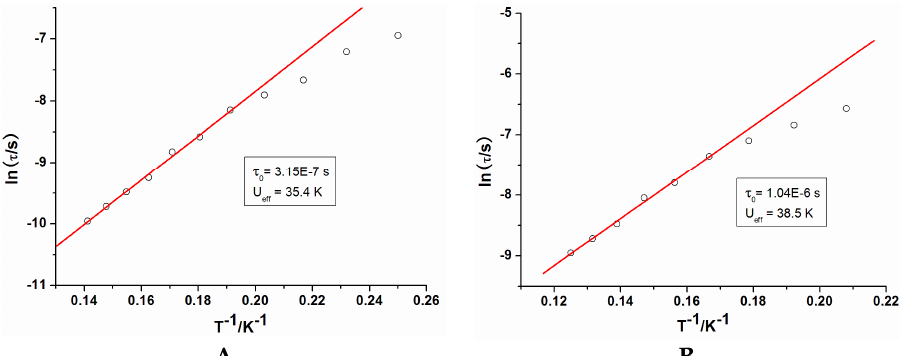
A B Figure 4. Magnetization relaxation time ( τ ) vs. 1/T plots for 1 ( A ) under 2000 Oe dc field and 2 ( B ) Figure 4. Magnetization relaxation time ( τ ) vs. 1/ T plots for 1 ( A ) under 2000 Oe dc field and 2 under a zero dc field. ( B ) under a zero dc